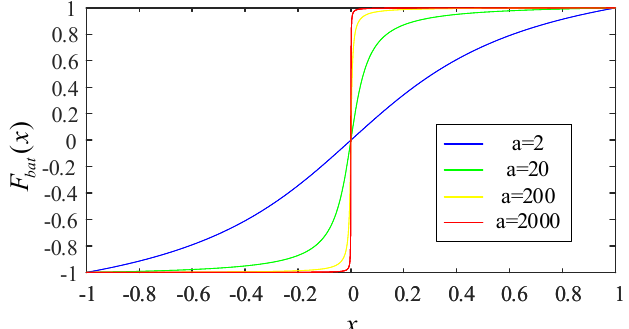
Figure 5. Diagram of virtual force F bat − x function.